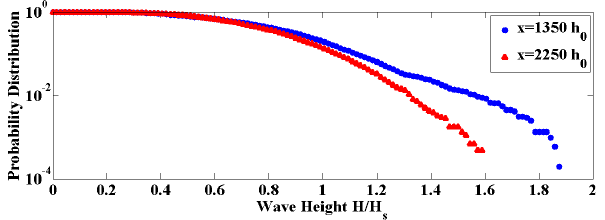
Figure 8. Variation of the skewness (a) and kurtosis (b) in the water of variable depth with initial value Ur = 2.06 (dashed line). The same variation in the water of constant depth h 0 = 5 m with Ur = 0.43 (solid line). Variable depth profile with L = 30 h 0 (c).